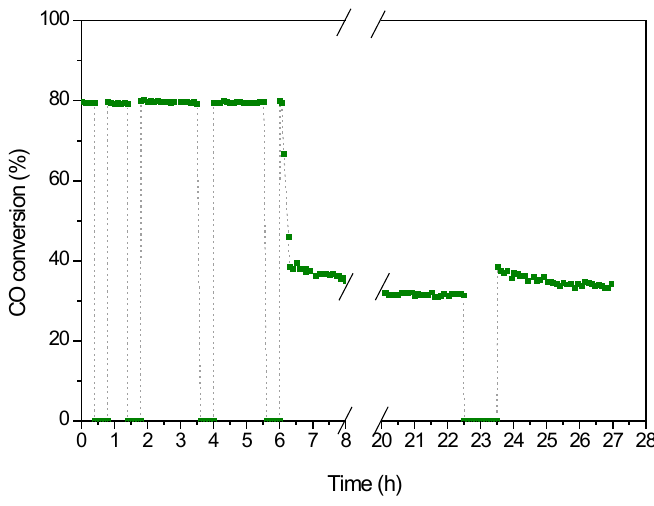
Figure 4. Stability test: start/stop cycles of the Ni-CeO 2 /C catalyst at 250 °C. Gas mixture: 7 mol% CO, 30 mol% H 2 O, 50 mol% H 2 , and 9 mol% CO 2 balanced in